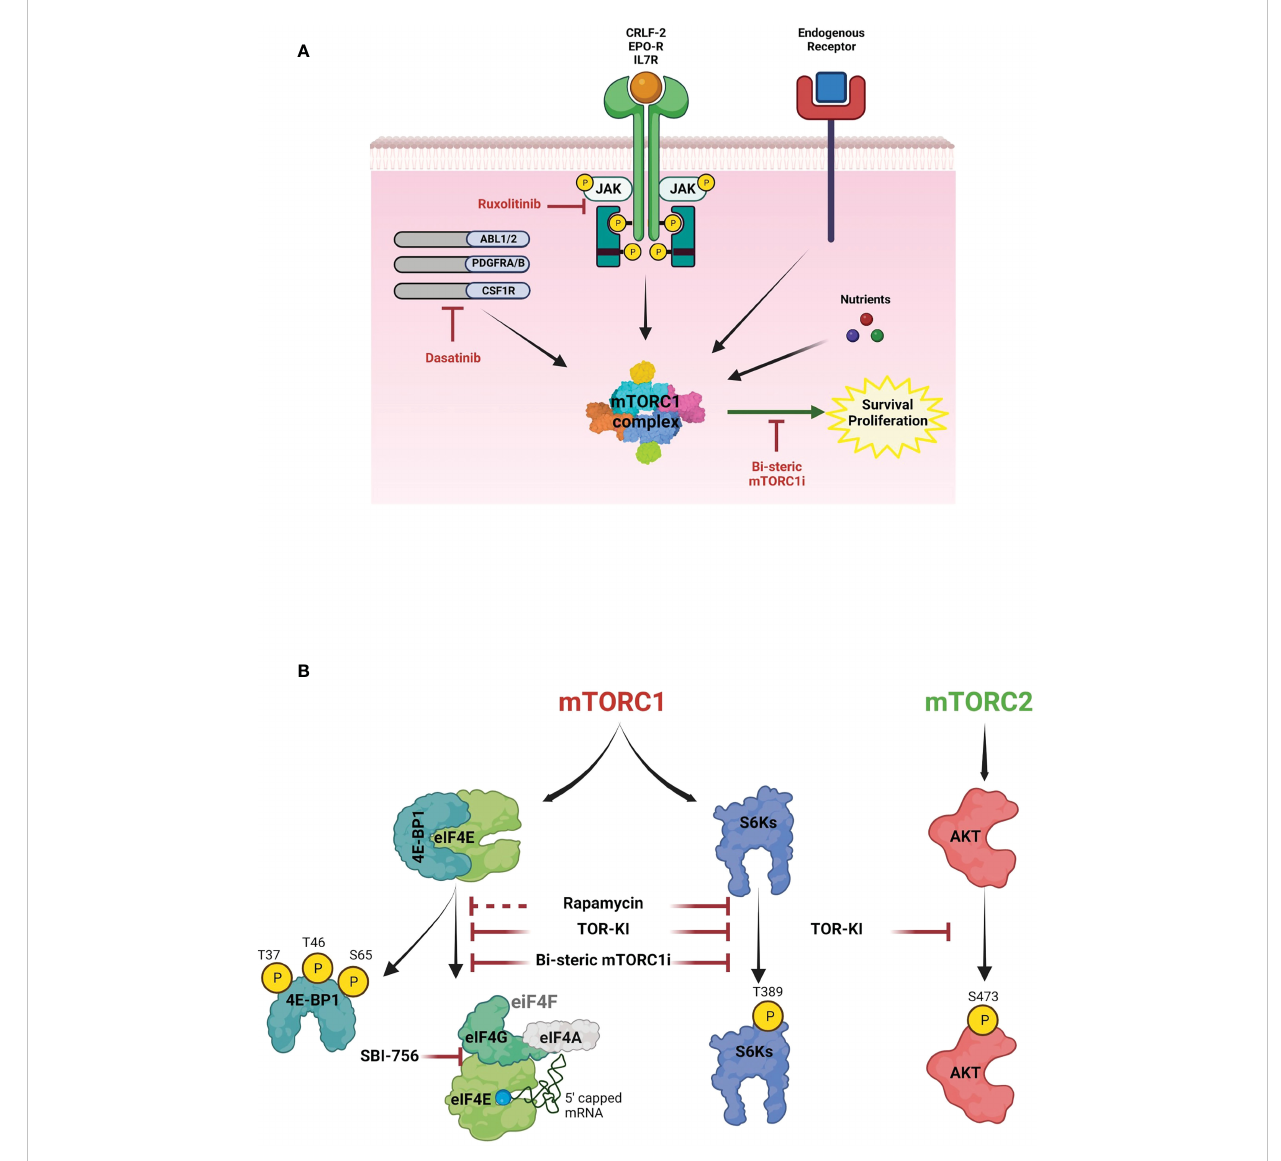
FIGURE 1 The role of mTOR signaling in B-ALL survival. (A) Schematic diagram of survival signaling pathways in B-ALL cells. mTORC1 contains the raptor subunit and other components that integrate signals from cytokine receptors, growth factors and nutrients to activate mTOR kinase activity. In Ph+ B-ALL, the BCR-ABL fusion tyrosine kinase (TK) increases activity of mTORC1 and other kinases. In Ph-like B-ALL, other genomic rearrangements ( CRLF2, EPOR, IL7R, ABL1, ABL2, PDGFRA, PDGFRB, CSF1R ) and/or JAK mutations activate TK signaling. Although clinically used TKIs (dasatinib, ruxolitinib) suppress oncogenic TK signaling, mTORC1 activity is largely maintained via nutrients and endogenous cytokine and growth factor receptors, thus promoting cell cycle progression and survival. Targeting this signaling with a selective bi-steric mTORC1 inhibitor (mTORC1i) has potential to enhance TKI cytotoxicity. (B) mTOR pathway. Two mTOR complexes, mTORC1 and mTORC2, have different substrates and together coordinate a complex network of anabolic pathways in response to signals from growth factors and oncogenes. Key substrates include ribosomal S6 kinases (S6Ks) and eIF4E-binding proteins (4E-BPs). mTORC1 phosphorylates 4E-BPs to promote eIF4F assembly. eIF4E binds to the 7- methylguanylate (m7G) cap present in most mRNAs and recruits the eIF4F complex to initiate cap-dependent translation. mTORC2 phosphorylates AKT and regulates cell proliferation and survival. First (rapamycin), second (TOR-KI) and third generation inhibitors (bisteric mTORCi) have different selectivity to inhibit the mTOR pathway. Notably, rapamycin is an allosteric inhibitor that inhibits phosphorylation of some substrates (e.g., S6Ks) more than others – particularly 4E-BP1. TOR-KIs act through an ATP-competitive mechanism to fully inhibit mTORC1 substrate phosphorylation but also inhibit mTORC2, thus suppressing AKT activity. Bi-steric mTORC1 inhibitors combine the mTORC1-selectivity of rapamycin with the complete kinase inhibition of TOR-KIs. The fi gures were created with